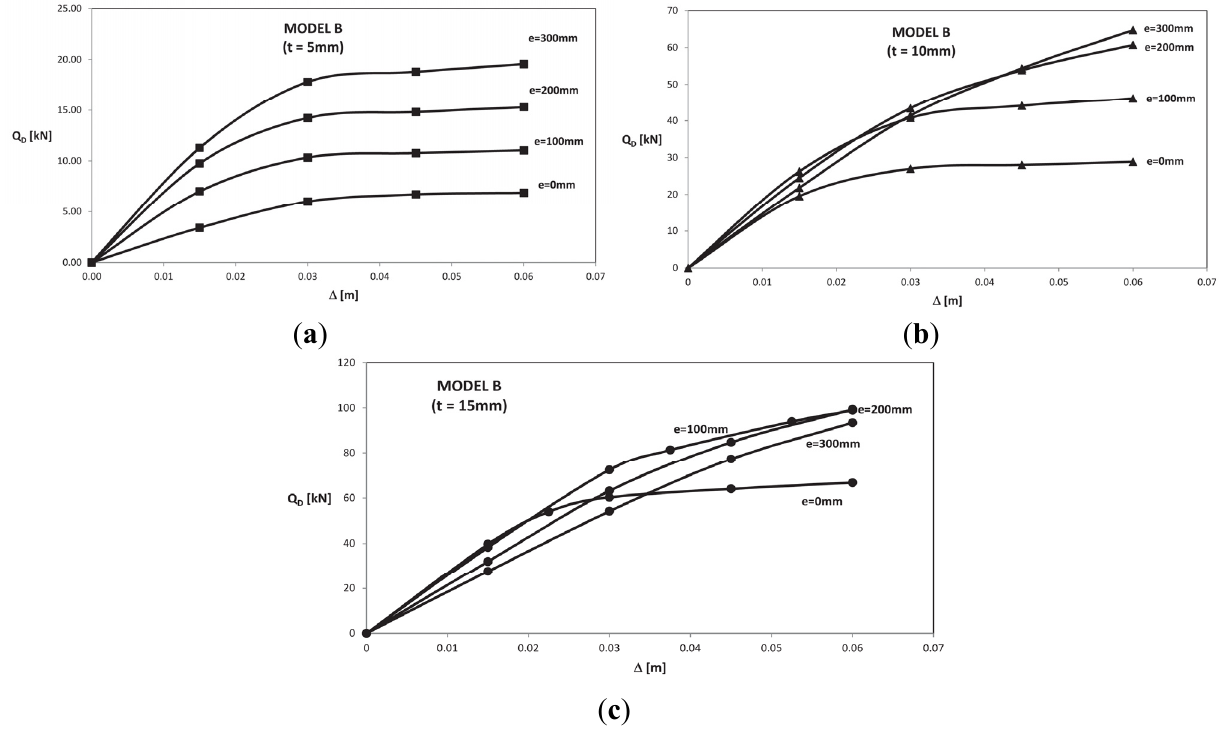
Figure 11. Model B: Pushover curves for different eccentricity e and plate thickness t : ( a ) t = 5 mm; ( b ) t = 10 mm; ( c ) t =